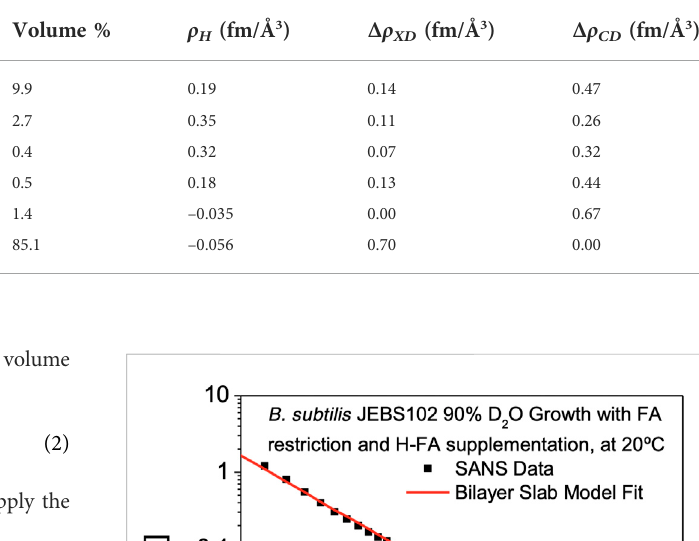
TABLE 1 Abundances and selected physical properties of major cellular species.